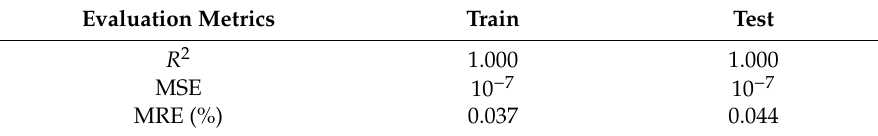
Figure 7. The deviation between the obtained data from plants and predicted mercury emissions. Table 1. Statistical analysis of the model for all